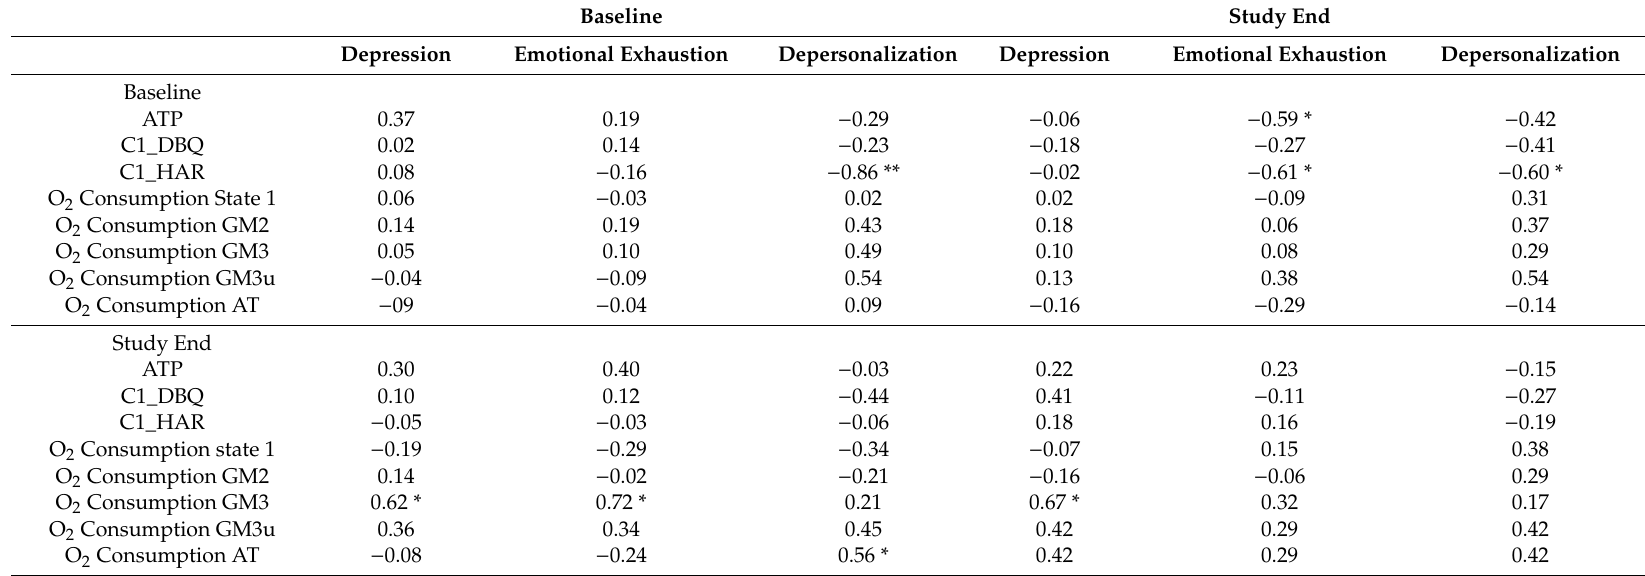
Table 4. Correlation coe ffi cients between symptoms of depression and burnout and mitochondrial activity levels in individuals with burnout. Baseline Study End Depression Emotional Exhaustion Depersonalization Depression Emotional Exhaustion